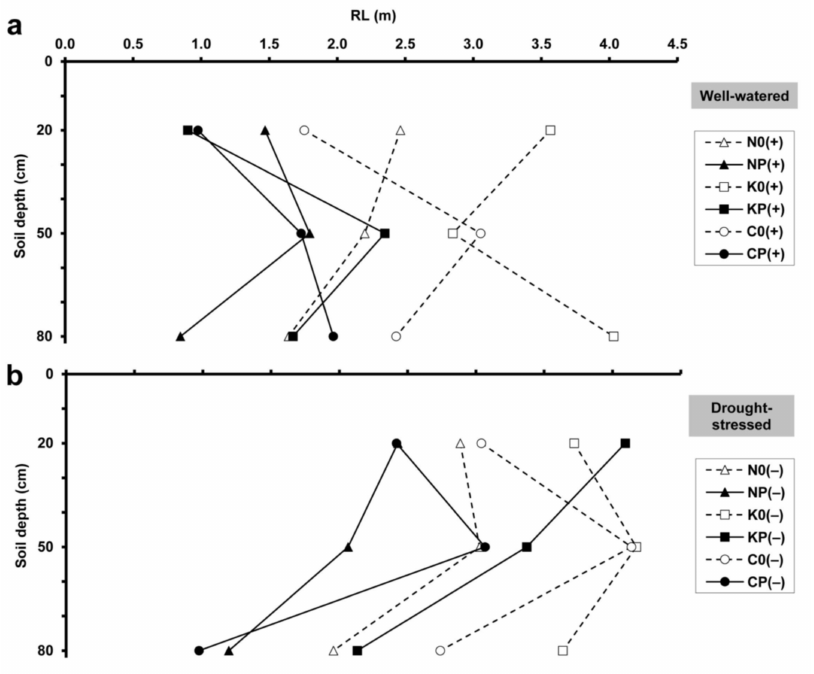
Figure 3. Maximum root length (RL) at 20, 50 and 80 cm soil depths, obtained by minirhizotron image analysis, under ( a ) well-watered and ( b ) drought-stressed conditions. For treatment codes, see Figure